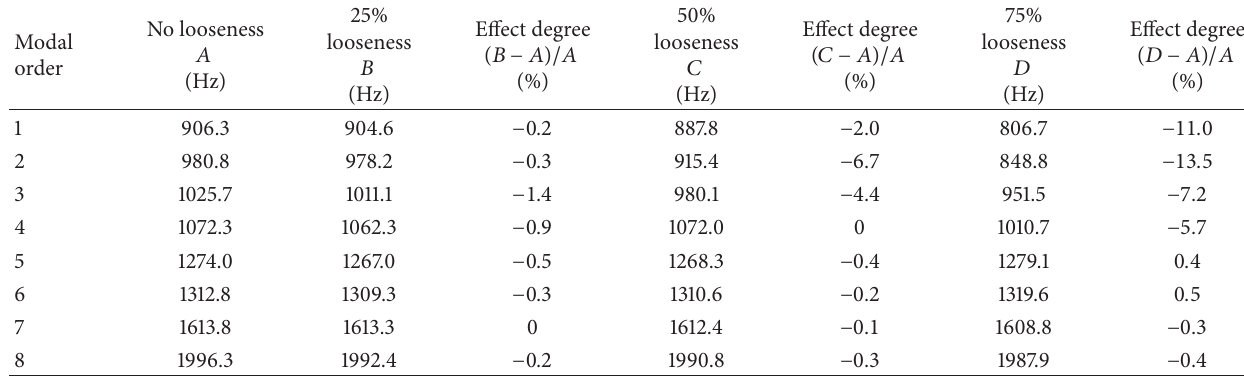
Table 10: Natural frequencies of TCS under BLB with different looseness levels.